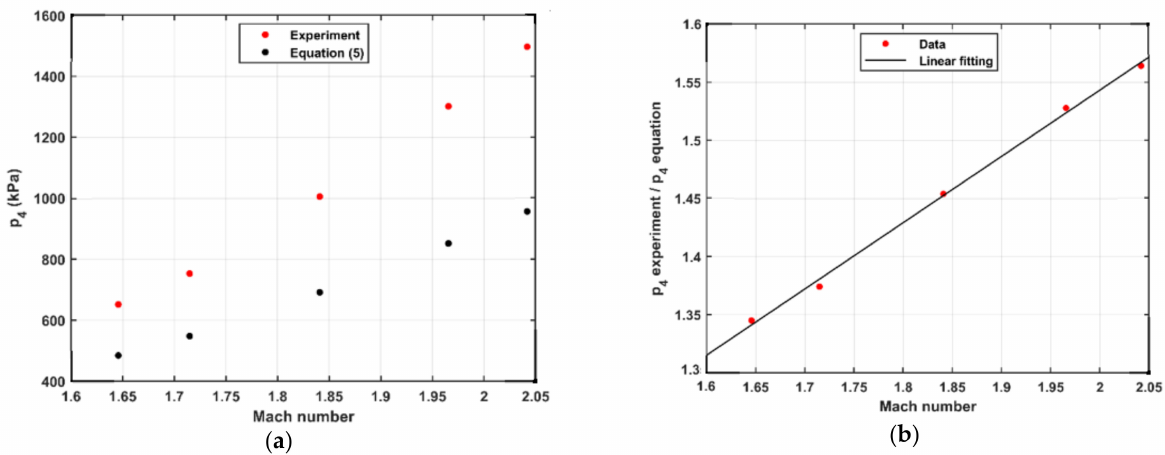
Figure 6. ( a ) The driver pressure ( p 4 ) as a function of Mach number and ( b ) ( p 4 experiment/ p 4 equation) as a function of Mach number when using He as a driver gas; p 1 is 100